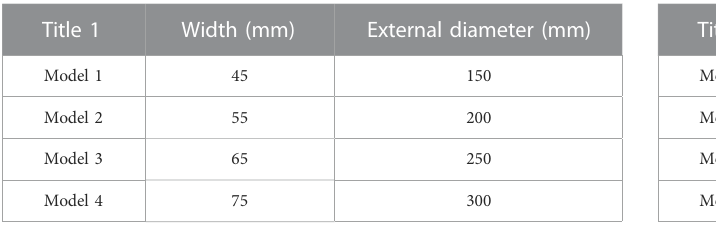
TABLE 1 The size of the outer ring. TABLE 2 The size of the inner